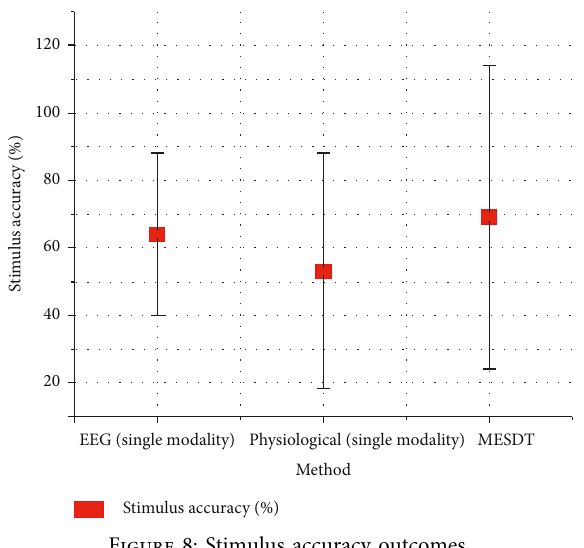
Figure 8: Stimulus accuracy